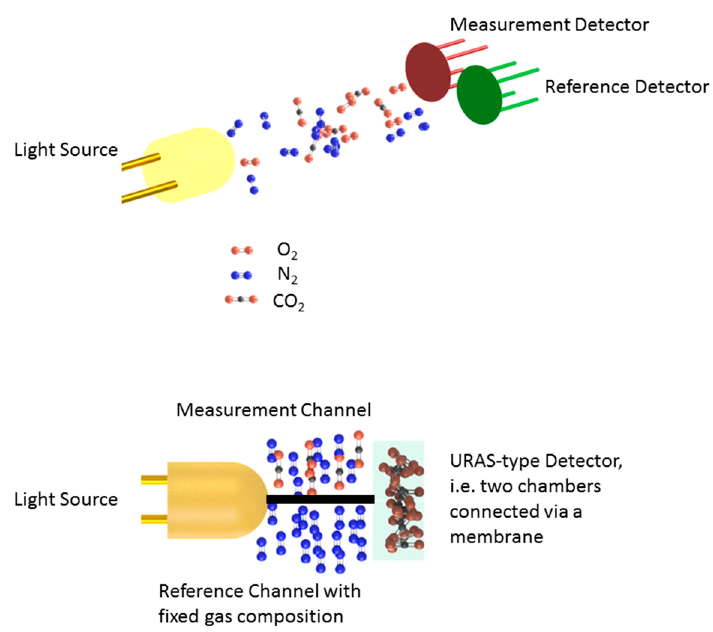
Figure 3. Comparison between a nowadays commonly used NDIR setup ( top ) and the URAS setup ( bottom ). ( Top ) Two detectors with different spectral response functions act as a measurement and reference channel, respectively. ( Bottom ) The URAS detector consists of two chambers filled with the gas to be detected and connected via a membrane. The optical path is divided into a reference part with a fixed gas composition and a measurement part containing the analyte.